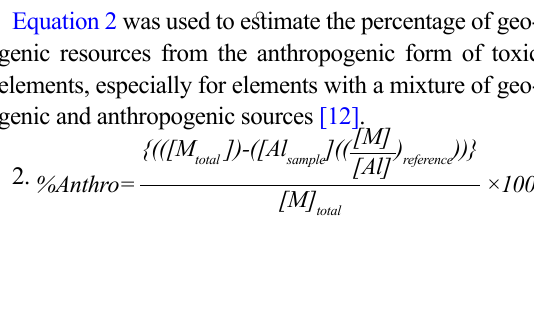
Bineshpour M, et al. Health Risk and Soil Contamination in Arak City. J Adv Environ Health Res. 2021;